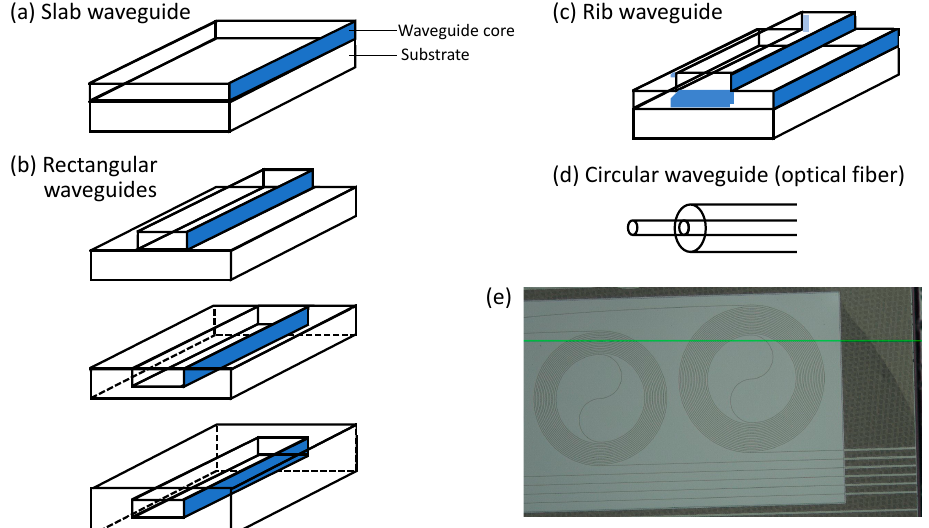
Figure 2. ( a – d , adapted from [25]) Basic waveguide structures: slab waveguide, rectangular (chan- nel/strip/wire) waveguide, and circular waveguide (optical fiber). Slot waveguides, not shown in this figure, consist of two rectangular waveguides positioned closely together in parallel. ( e ) Laser confocal microscope image of a WERS chip with spiral waveguides. The green line is a horizontal imaging